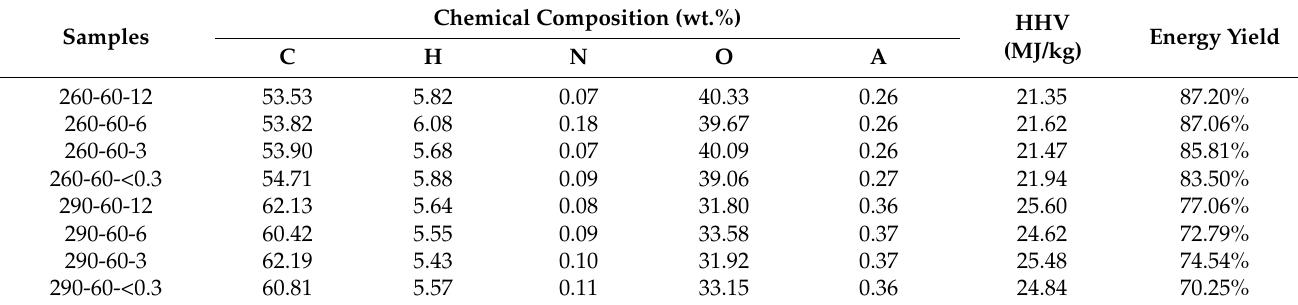
Table 1. Effect of particle size on the chemical composition, HHV, and energy yield of the solid product from Paulownia wood torrefaction under different